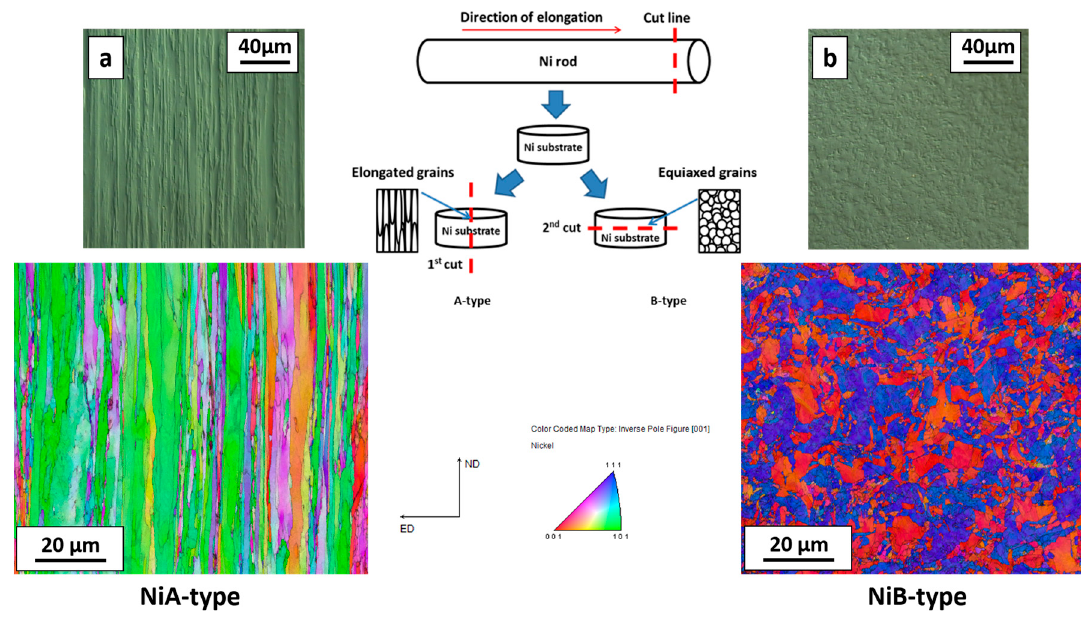
Figure 3. The scheme of the preparation of nickel substrates with their optical microstructures and electron backscattered diffraction (EBSD) maps ( a ) NiA-type, ( b ) NiB-type.